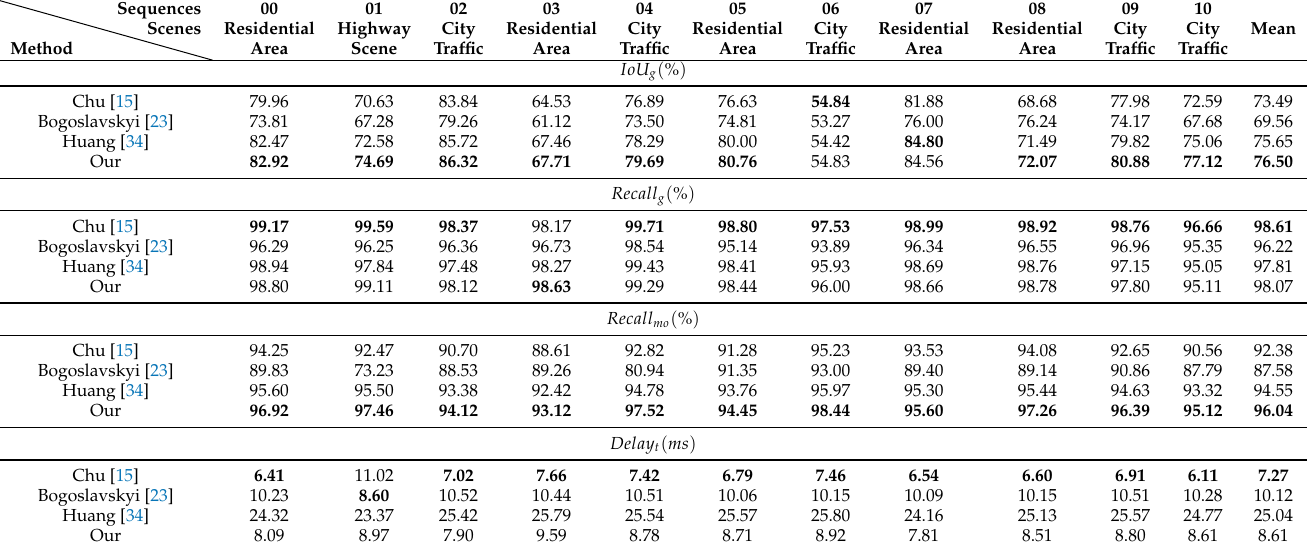
Table 2. The evaluation results on the Semantickitti